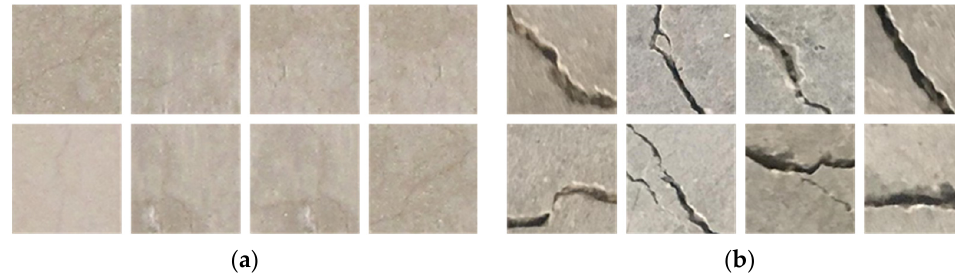
Figure 2. Crack patch samples of ( a ) the dataset used in this paper and ( b ) the dataset from [41].